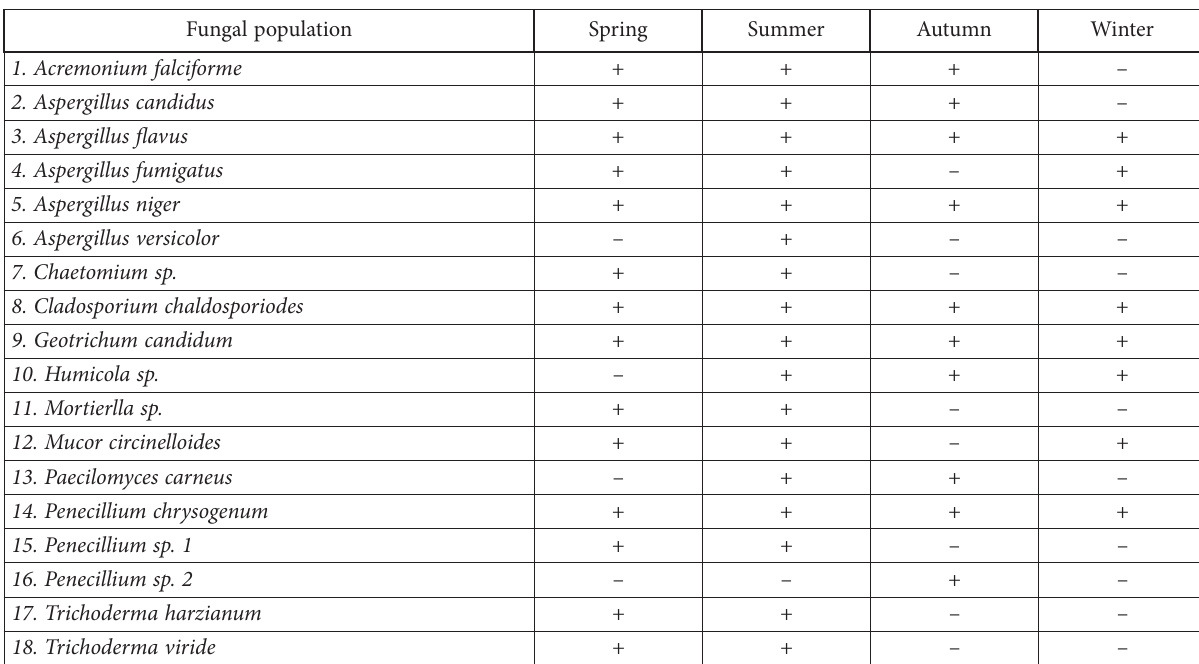
Table 7. Fungal diversity at